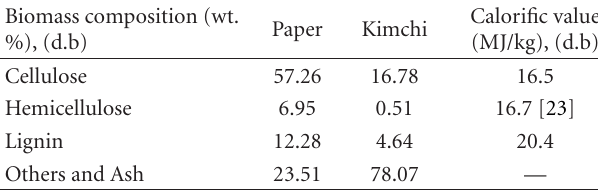
Table 1: Biomass composition of paper and kimchi. Biomass composition (wt.